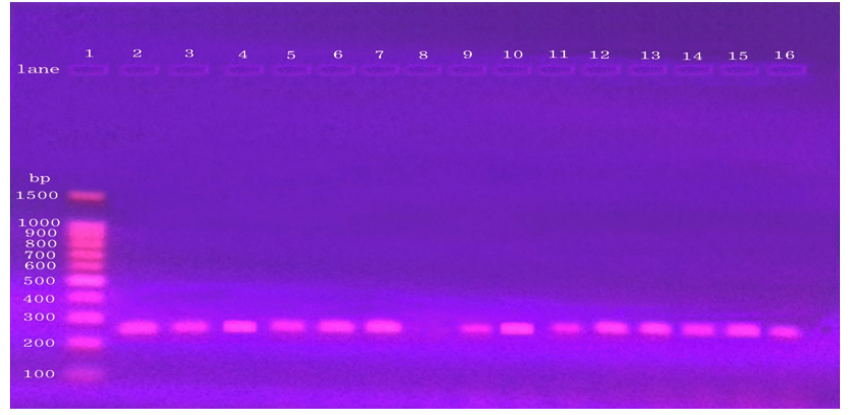
Fig. 3. Gel electrophoresis shows Nuc gene